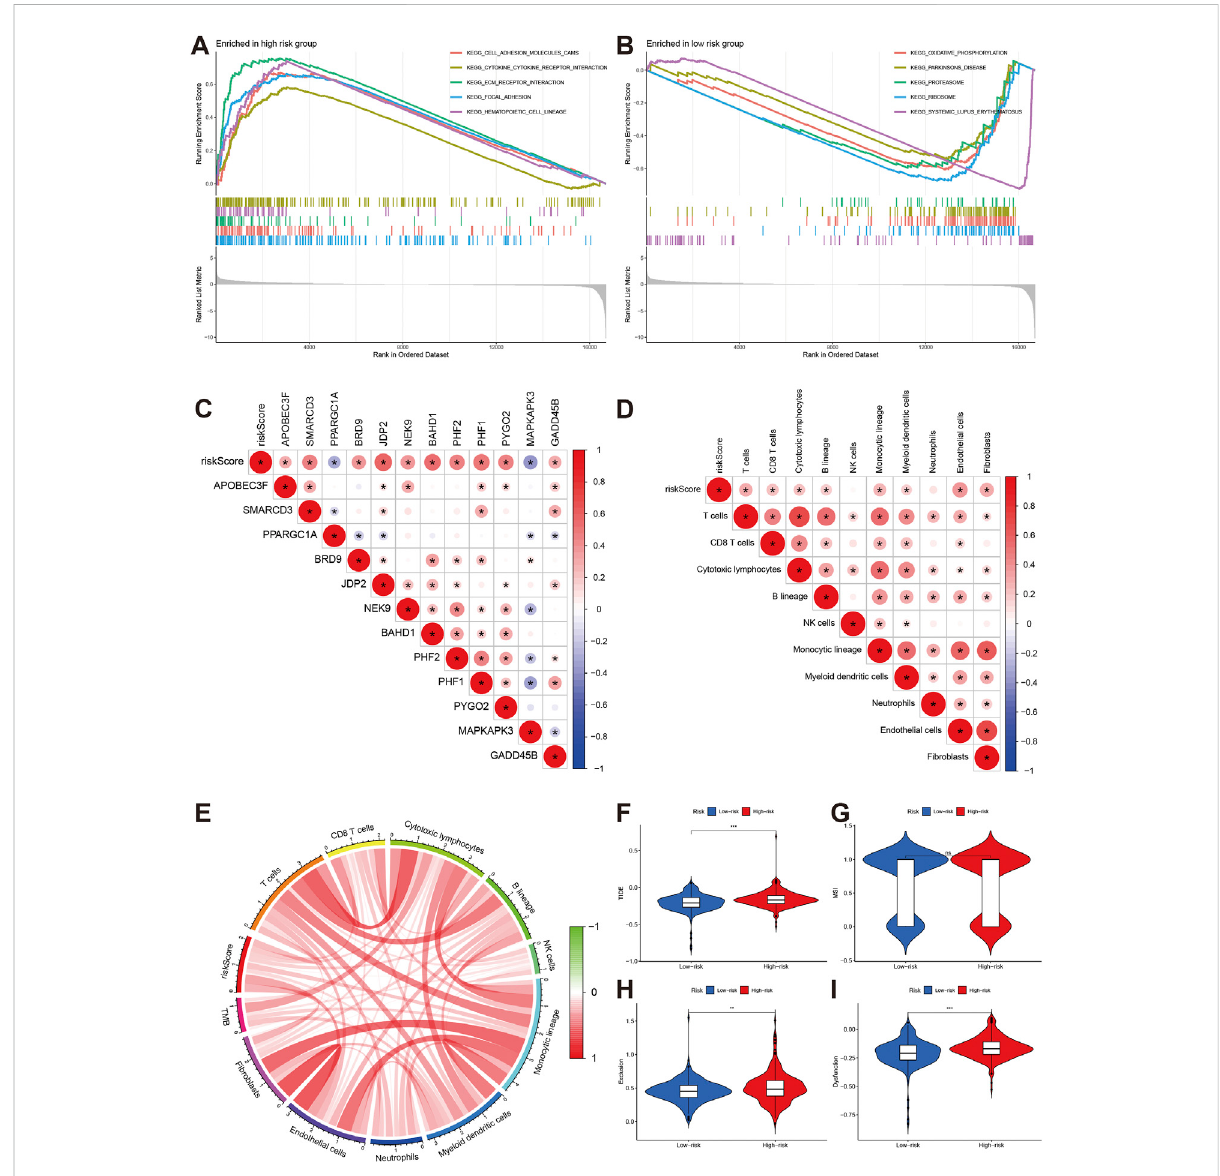
FIGURE 8 Pathway enrichment and immune in fi ltration of different risk groups. (A,B) KEGG pathways enrichment of high-risk and low-risk groups. (C,D) Thecorrelationsofriskscoreandsignaturegeneandimmunecells. (E) correlationsofriskscorewithTMB. (F – I) ComparisonsofTIDE,MSI,exclusion and dysfunction between high-risk group and low-risk